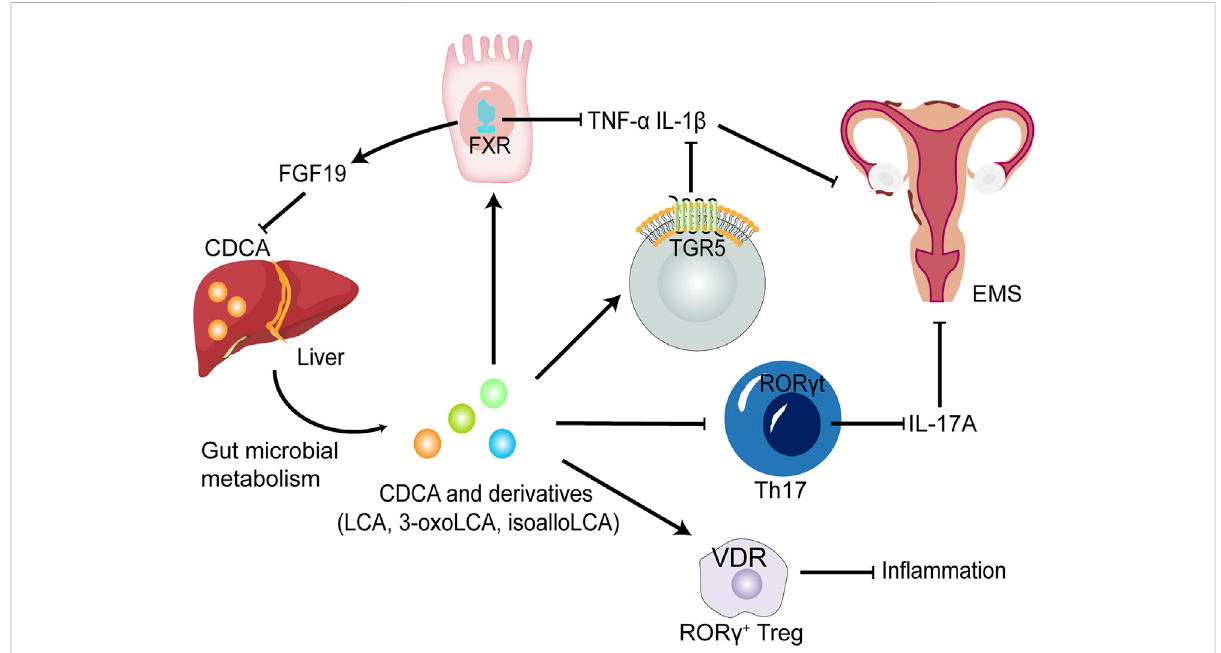
FIGURE 3 The potential roles of CDCA and derivatives in EMS. CDCA produced from the liver is converted into LCA, 3-oxoLCA and isoLCA after being metabolized by GM. FXR and TGR5 activated by CDCA and derivatives suppress proin fl ammatory cytokine expression, such as IL-1 β and TNF- α in dendriticcellsandmacrophages.CDCApromotethereleaseofFGF-19byactivatingFXR,therebyinhibitingtheproductionofCDCA,furtherforming anegative feedback regulation mechanism in normal environment. 3-oxoLCA and isoLCA inhibit the differentiation of Th17 cells expressing IL- 17A upon direct binding to ROR γ t. Decreased levels of proin fl ammatory cytokines could improve EMS. Furthermore, CDCA, LCA and 3-oxoLCA modulate ROR γ Tregs through the BA receptor VDR to suppress in fl ammation. FGF-19, fi broblast growth factor 19; ROR γ t, retinoic acid-related orphan receptor γ t; Treg cells, regulatory T cells; VDR, vitamin D